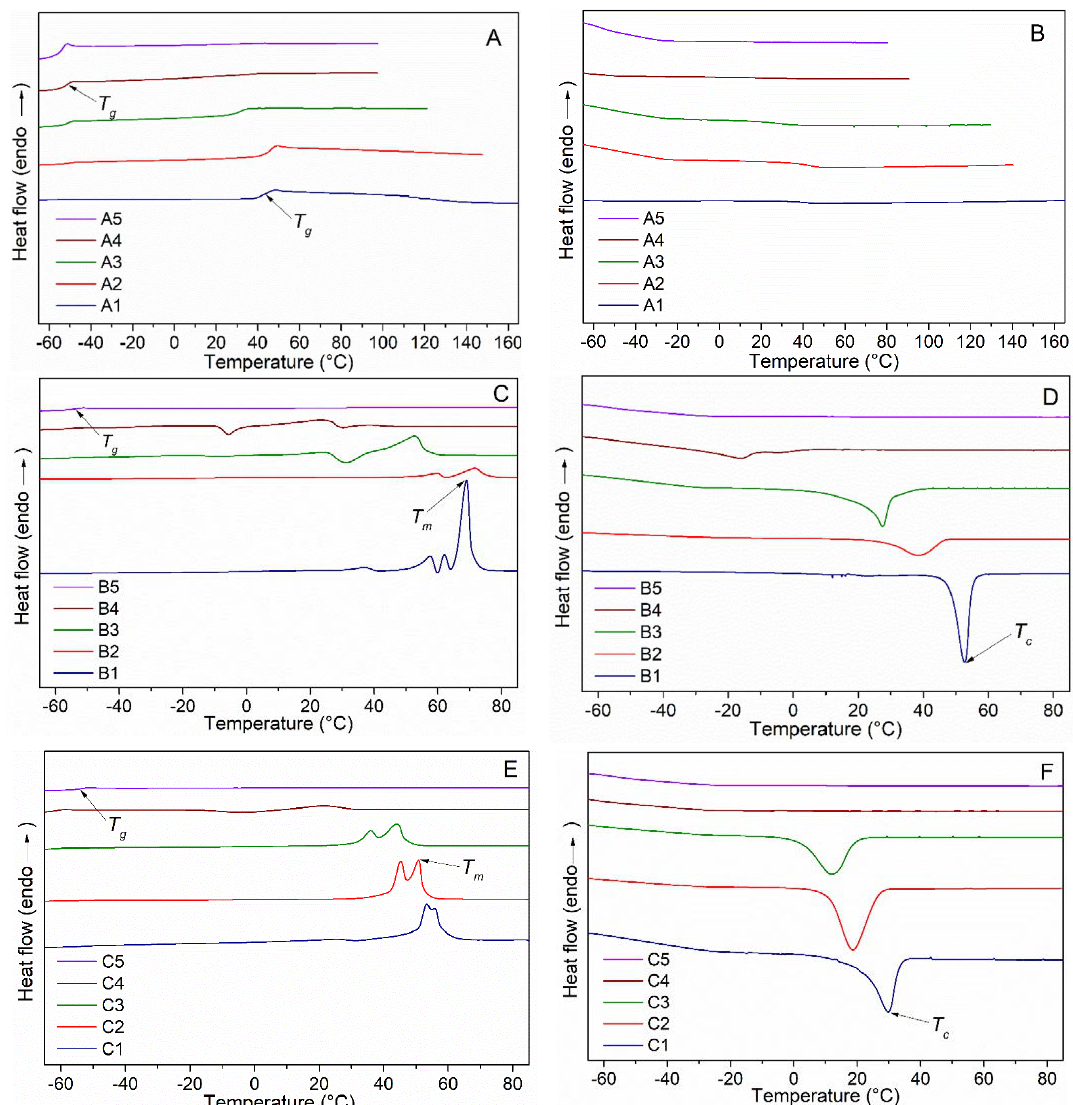
Figure 6. Thermograms of Series I–III. ( A ) heating-Series I; ( B ) cooling-Series I; ( C ) heating-Series II; ( D ) cooling-Series II; ( E ) heating-Series III; ( F ) cooling-Series III.